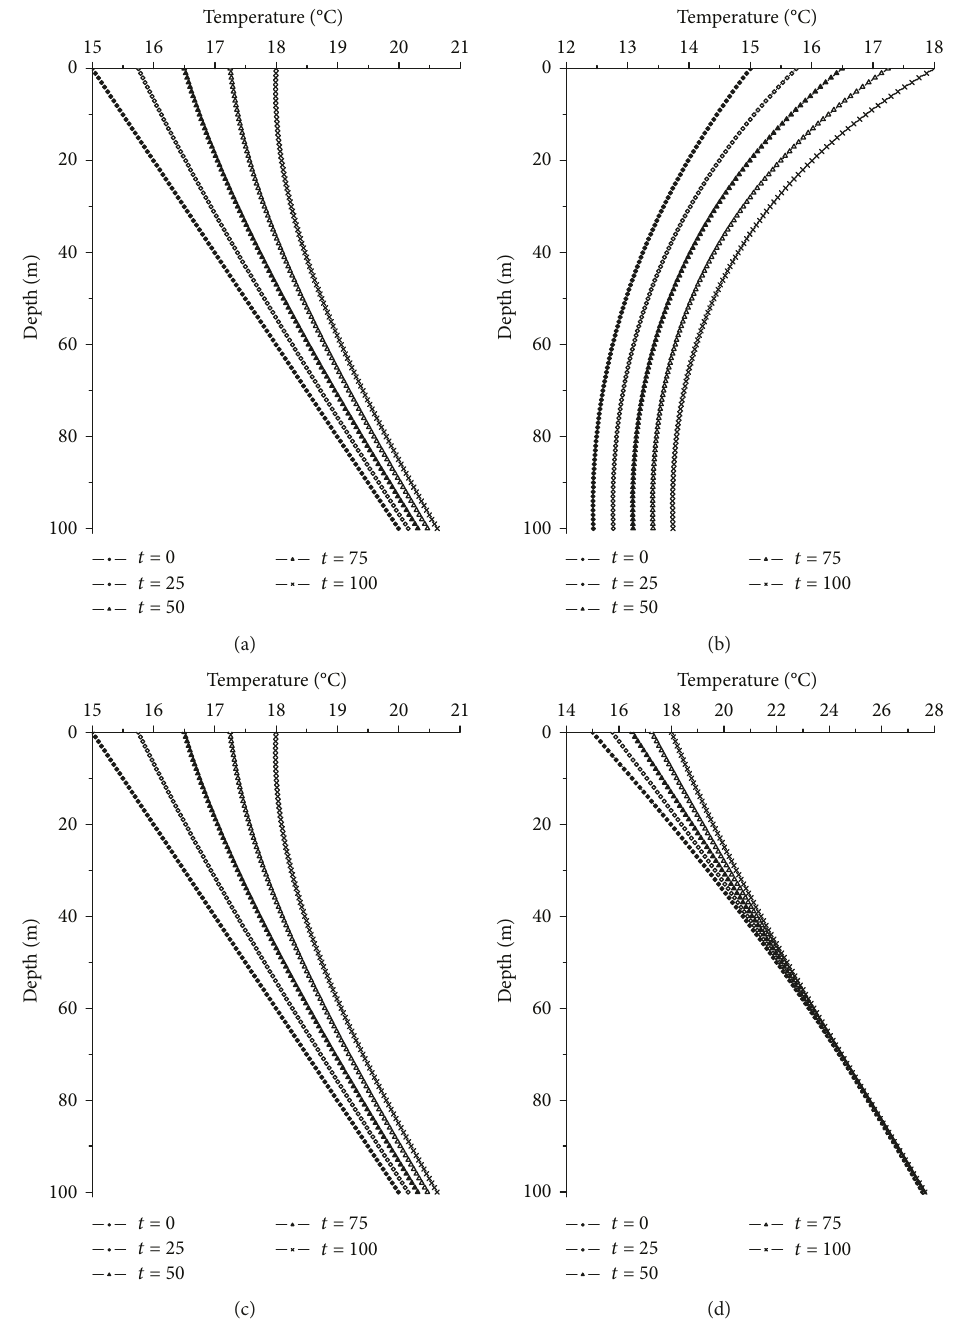
Figure 10: Surface warming-forced temperature-depth pro fi le variation at t =0, 25, 50, 75, and 100 years under various water fl ow conditions: (a) only heat conduction, (b) x =1000m (recharge), (c) x =15,000m (intermediate), and (d) x =29,000m